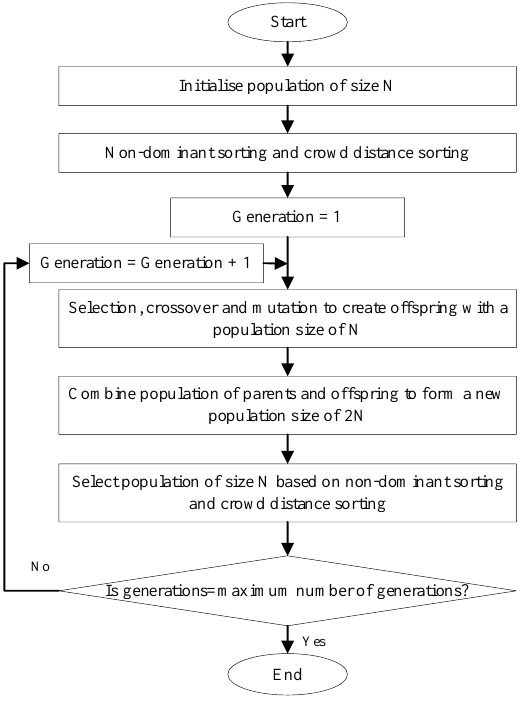
Figure 4. Flow chart of NSGA-II algorithm.